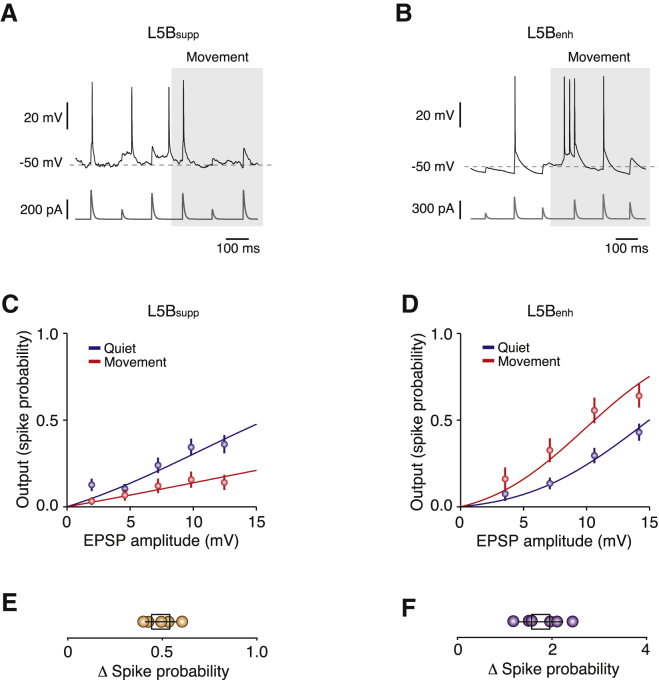
Input-Output Transformations in L5Bsupp and L5Benh Pyramidal Neurons during Movement(A and B) Representative voltage traces (upper trace, black) during somatic EPSC-like current injections in vivo (lower trace, dark gray) in L5Bsupp (A) and L5Benh (B) pyramidal neurons during quiet wakefulness and movement (light gray shading).(C and D) Input-output transformations in L5Bsupp (C, n = 5) and L5Benh (D, n = 6) neurons recorded in vivo during quiet wakefulness (blue) and movement (red). Symbols represent mean ± SD; solid lines are fits to a truncated error function.(E and F) Mean change in spike probability for L5Bsupp (E, n = 5) and L5Benh (F, n = 6) neurons. Filled symbols represent data from individual neurons and black open squares represent mean ± SD.See also Figure S2.